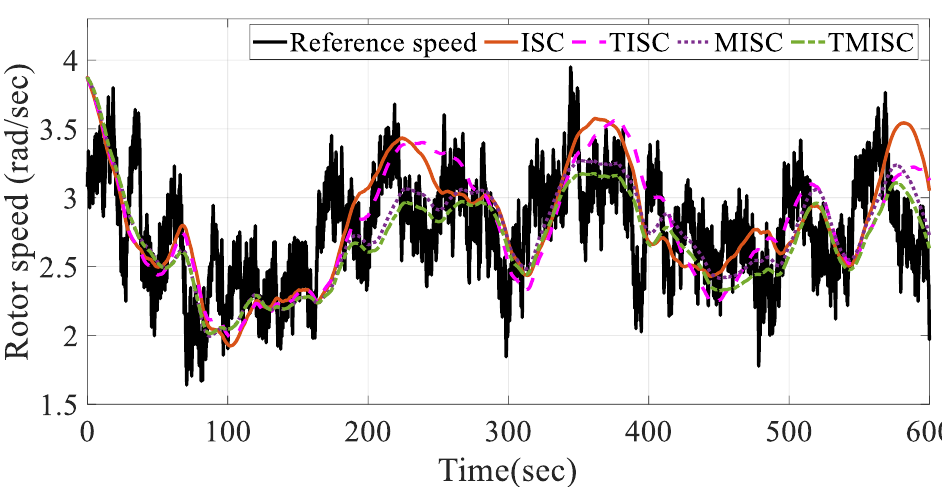
Figure 6. Rotor speed comparison for SC, TSC and Int TSC.